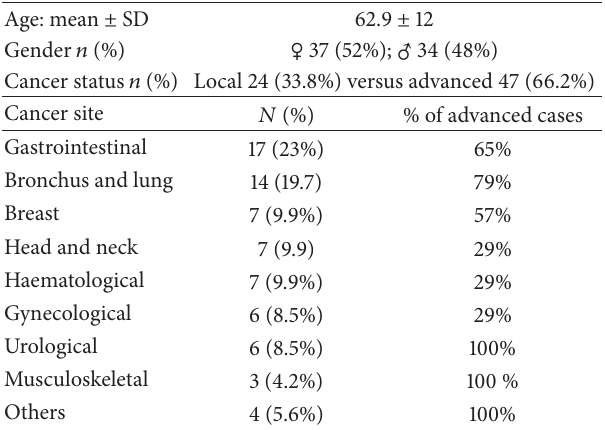
Table 1: Demographic and cancer status.